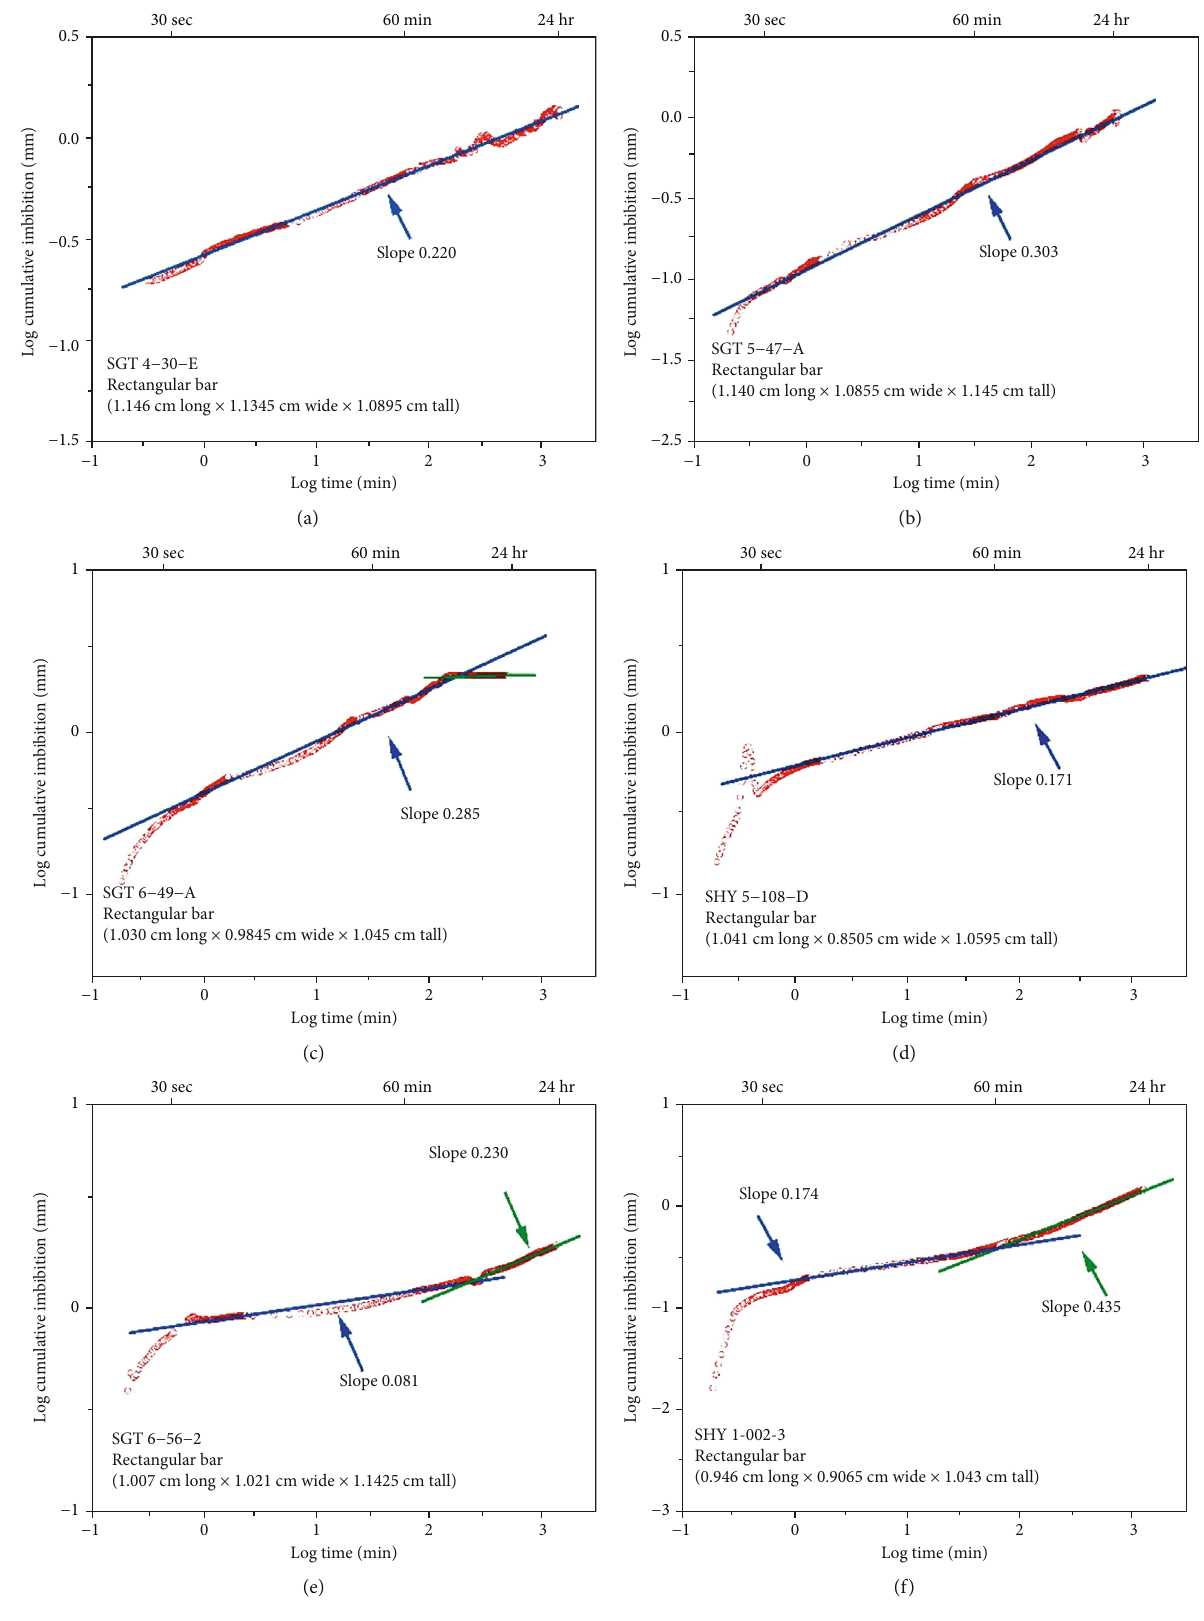
Figure 11: Spontaneous imbibition results for six representative carbonate samples from the Xiaoerbulake